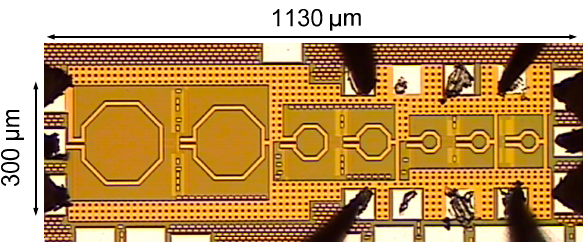
Figure 12. Die micrograph of the developed FQ chip and size of the devices.